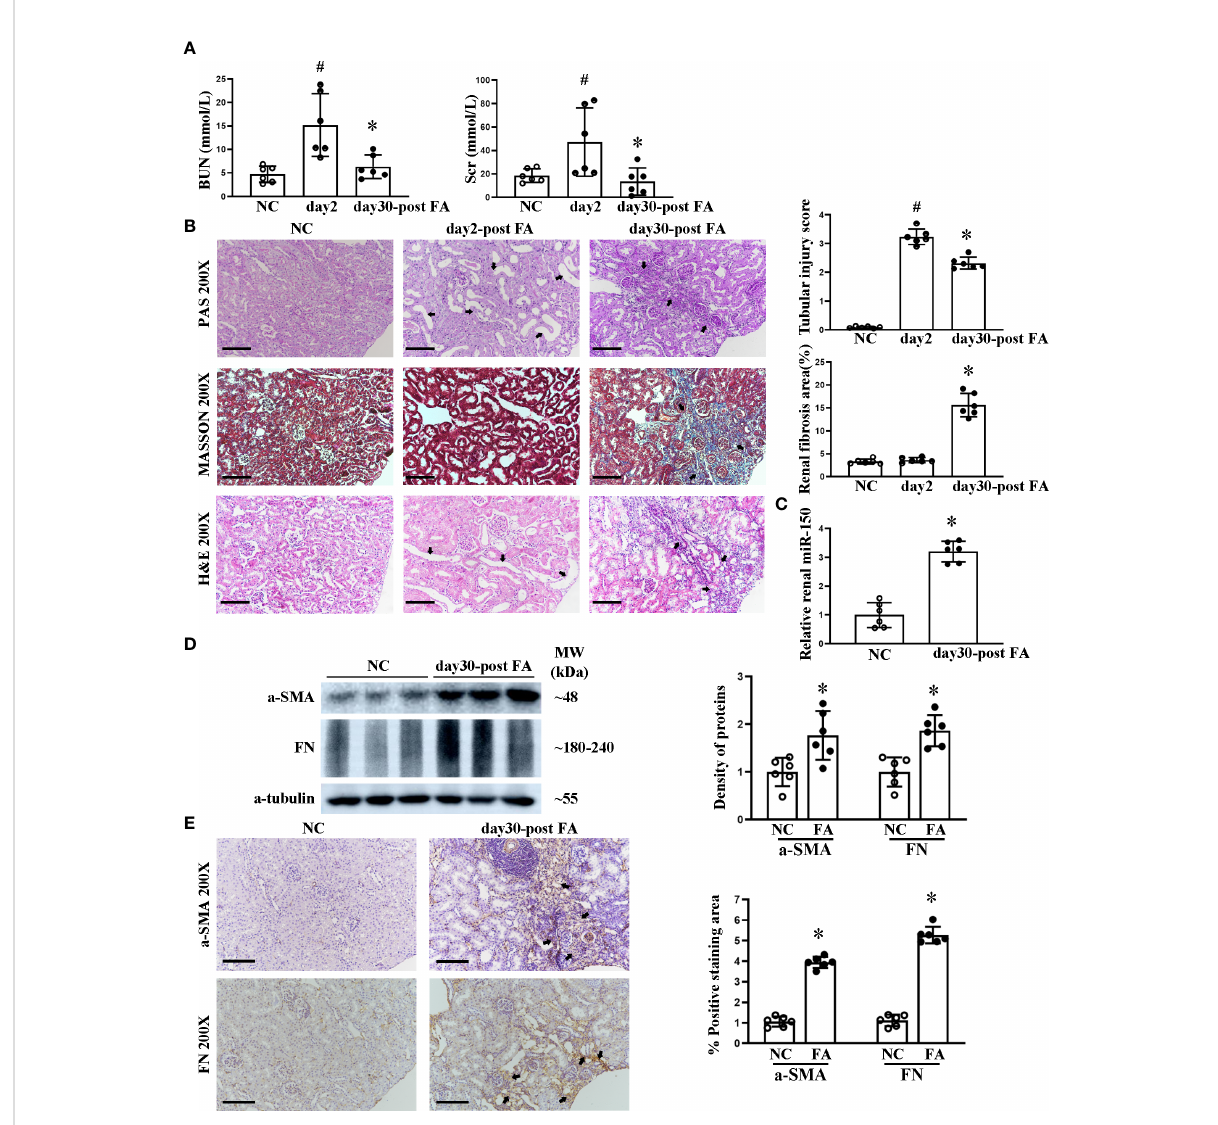
FIGURE 1 Course of folic acid-induced kidney injury and renal miR-150 expression in mice. The dynamic changes of renal function indicated by blood urea nitrogen and serum creatinine (A) . Histological morphological changes by periodic acid – Schiff, Masson, and H&E staining as well as semi- quanti fi cation of tubular injury score and renal fi brosis area (B) in mice after folic acid (FA) injection. Relative renal expression of miR-150 determined by qPCR (C) . Shown are the renal expression of pro fi brotic protein including a-SMA and fi bronectin by Western blotting and the density of the bands (D) and immunohistochemical (IHC) staining and their respective semi-quantitative analysis at day 30 after FA administration (E) . Data are presented as mean ± SD, n = 6. In (A, B) , # p < 0.05, day 2 post-FA mice vs. normal control (NC) mice. In (A) , * p < 0.05, day 30 post-FA vs. day 2 post-FA. In (B – E) , * p < 0.05, day 30 post-FA vs. NC mice. For PAS, Masson, H&E, and IHC, magni fi cation = ×200 and scale bar = 100 m